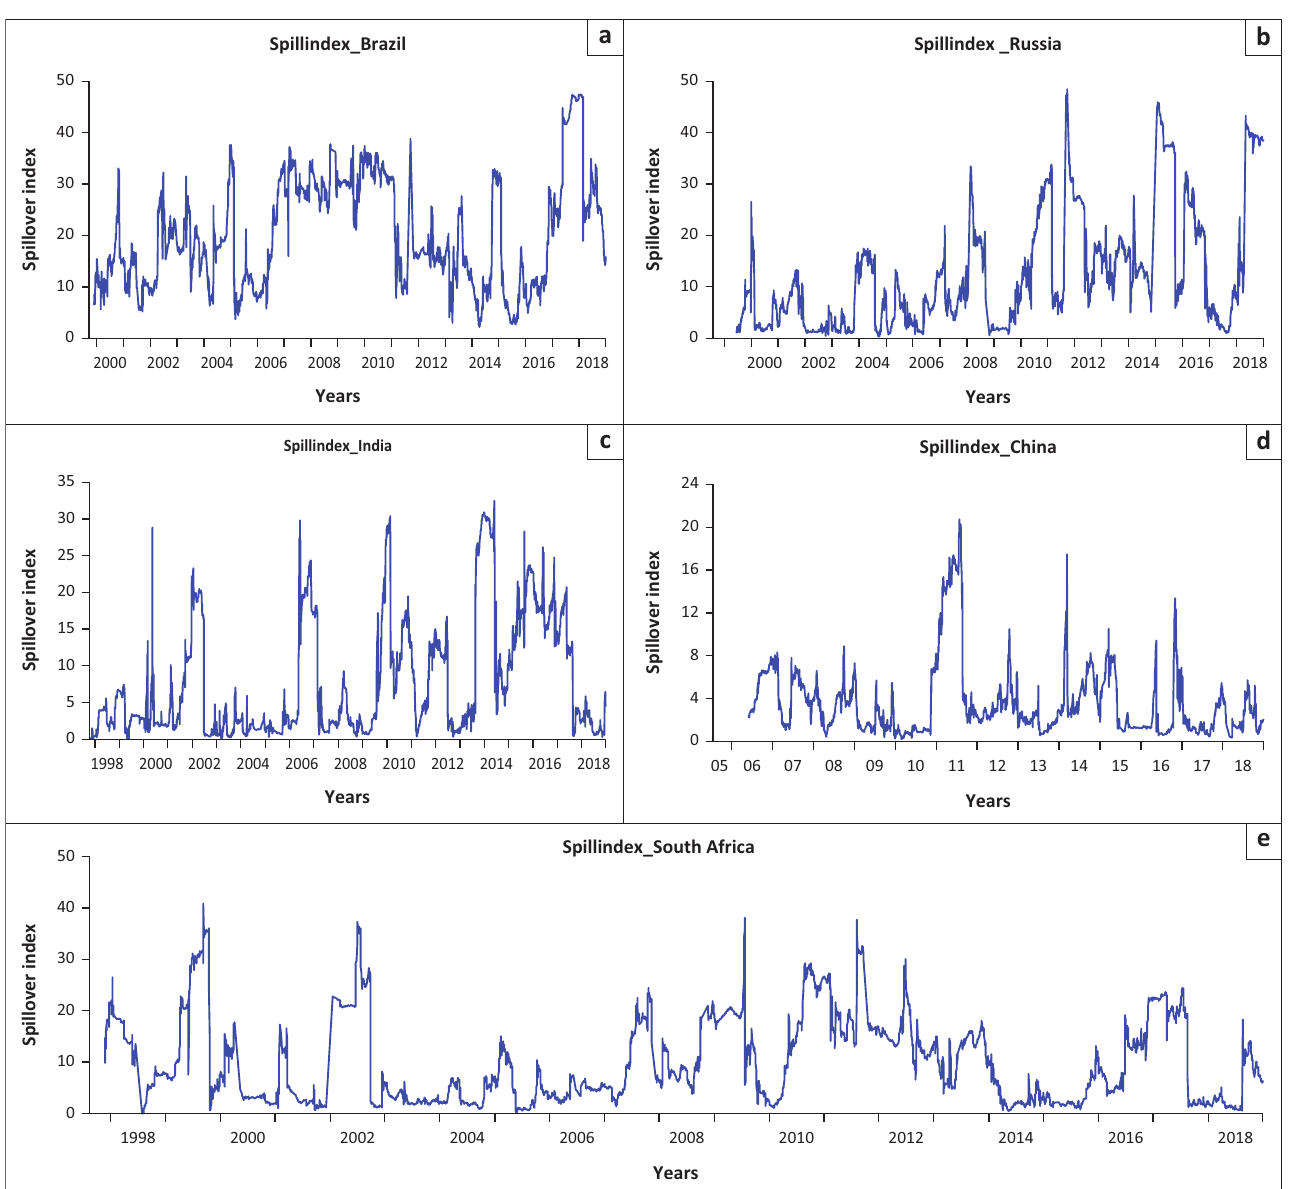
FIGURE 1: Time-varying spillover indexes – Brazil, Russia, India, China and South Africa cross-market, cross-country analysis